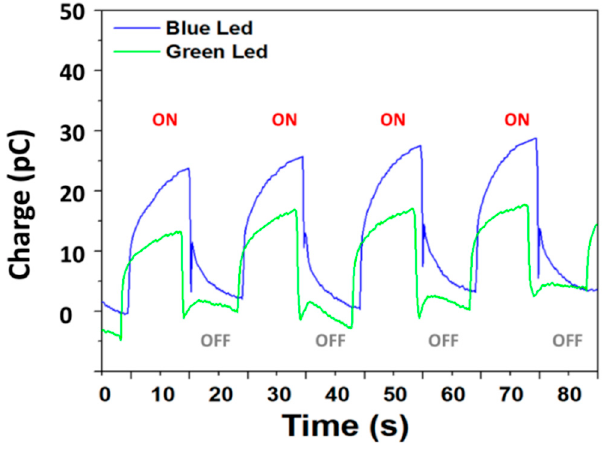
Figure 6. Charge–discharge behavior of terpolymer phosphor composite excited under blue and green LEDs.